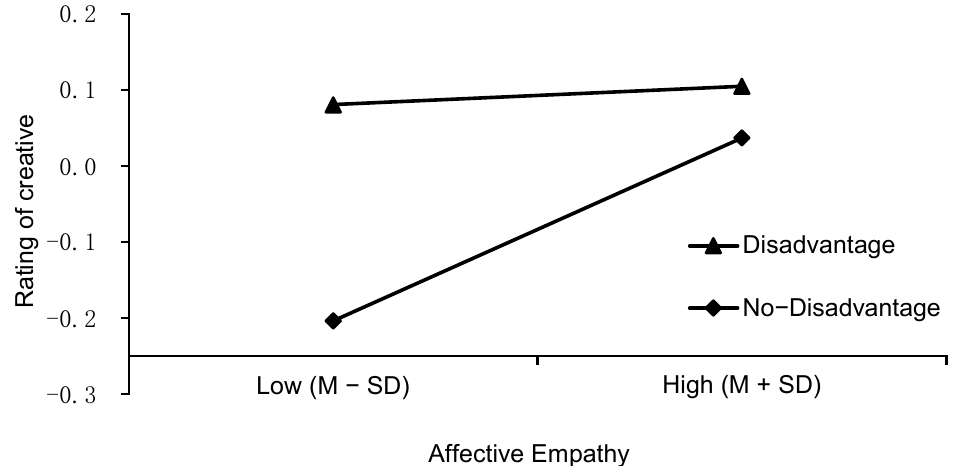
Figure 3. The interaction effect of affective empathy and the creator’s situation on creative evaluation.